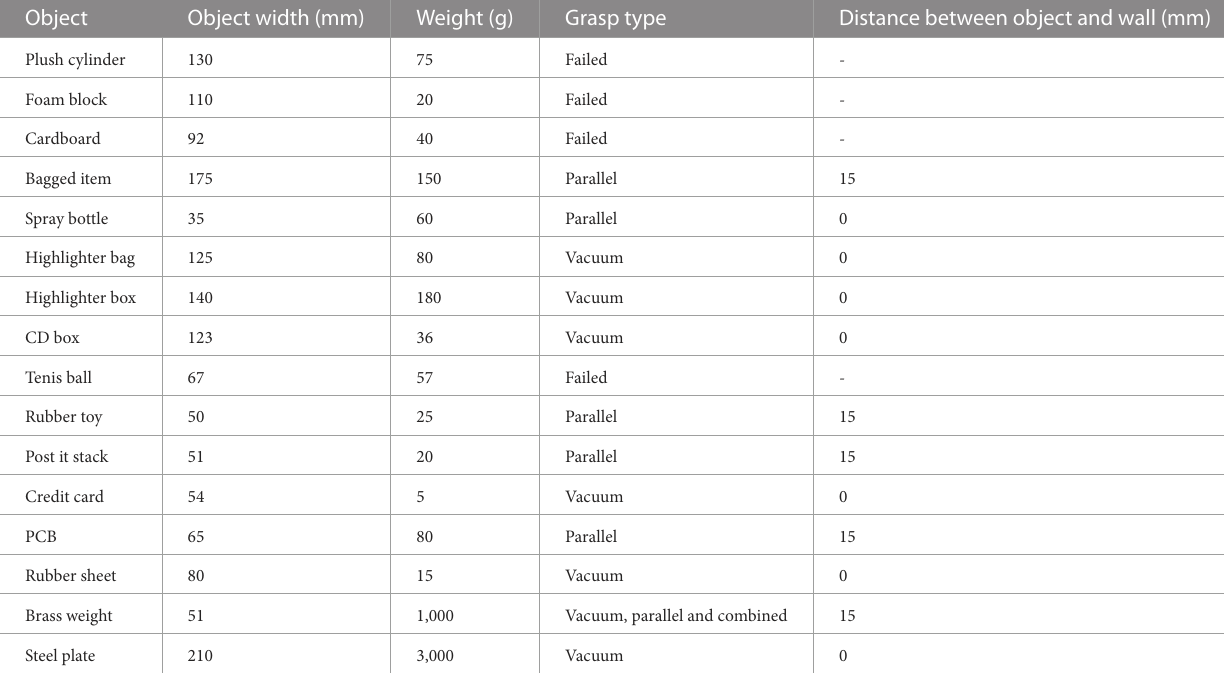
TABLE3 Resultsofgraspingtrialswith16differentobjects.